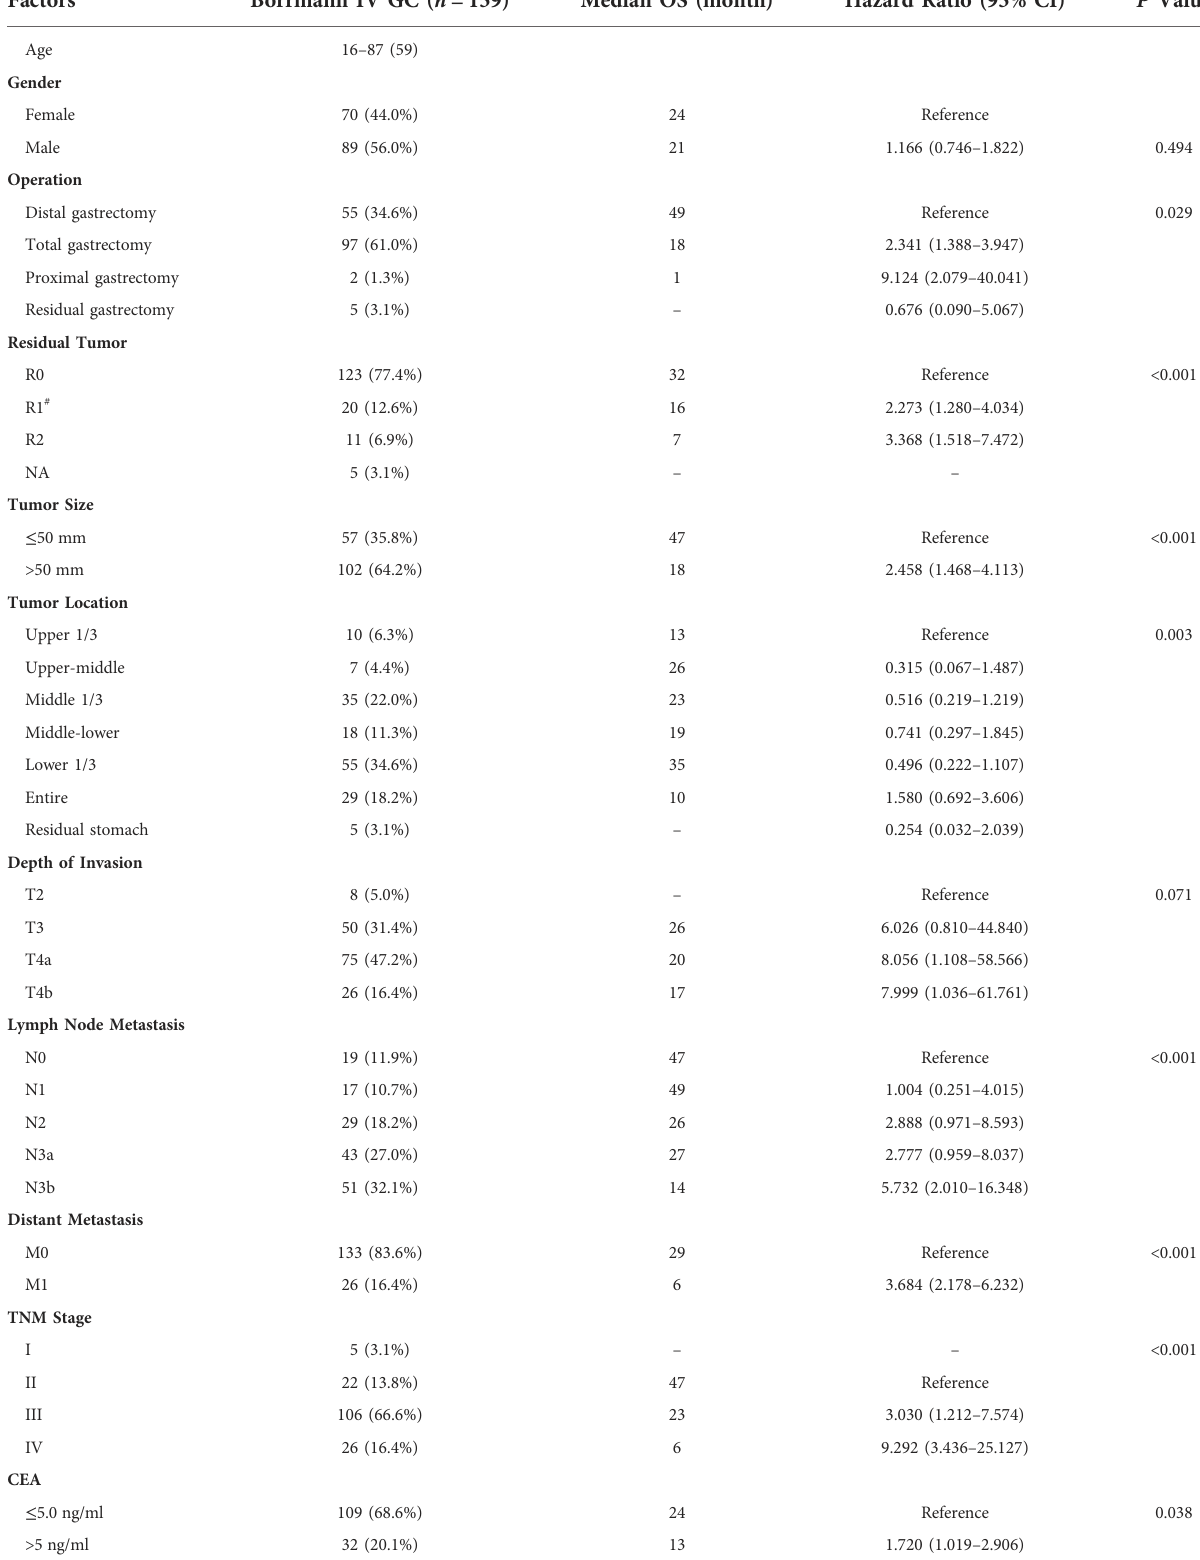
TABLE 1 Clinicopathological features and survival analysis of patients with Borrmann type IV gastric